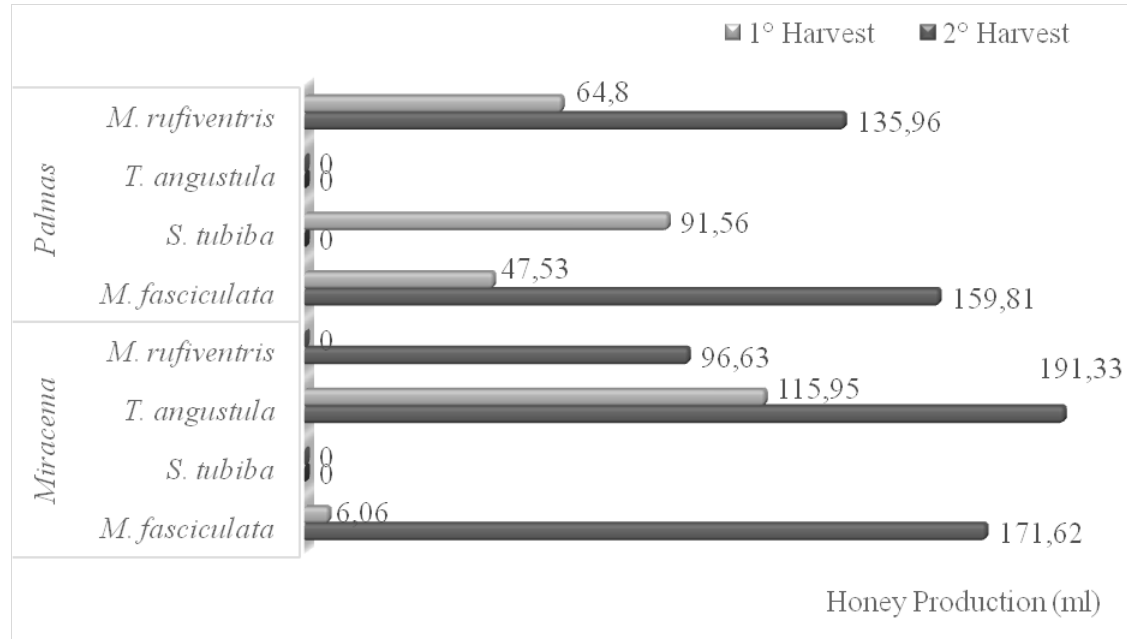
Fig 2 . Honey production from the first and second harvest in the municipalities of Miracema and Palmas (TO) , Brazil. T. angustula with the summation of 191.33 ml, followed Table 1 - Average production (ml) of honey from four species of stingless bees in the municipalities of Palmas and Miracema (TO), by M . fasciculata and rufiventris (171.62 and 96.63 ml), Brazil, in two harvest respectively. S. tubiba did not produce honey during this period. In the municipality of Palmas, honey production was not observed for S. tubiba and T. angustula bees, only for M. fasciculata and rufiventris, with averages of 159.81 and 135.96 ml, respectively (Fig 2).